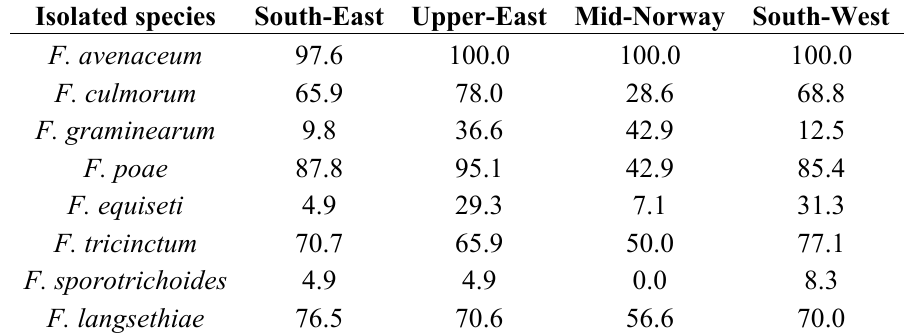
Table 3. Occurrence (%) of Fusarium spp. isolated from wheat samples from four regions in Norway from 1994 to 1996, as determined by Kosiak et al. [5].